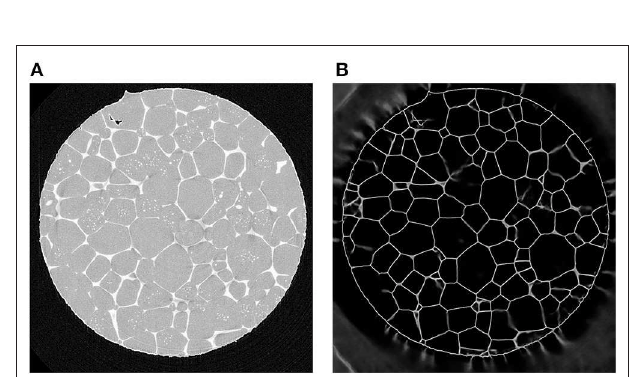
FIGURE 5 | (A) Two-dimensional cross-section of a CT reconstruction of Al-5 wt.% Cu with 7% (by volume) of liquid phase; the lighter gray pixels correspond to liquid regions located mainly at the boundaries between solid grains (darker gray pixels). (B) The corresponding output of a U-Net which was trained with 2D cross sectional